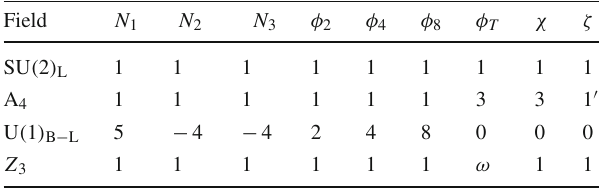
Table 2 Complete field content with their corresponding charges of the proposed model